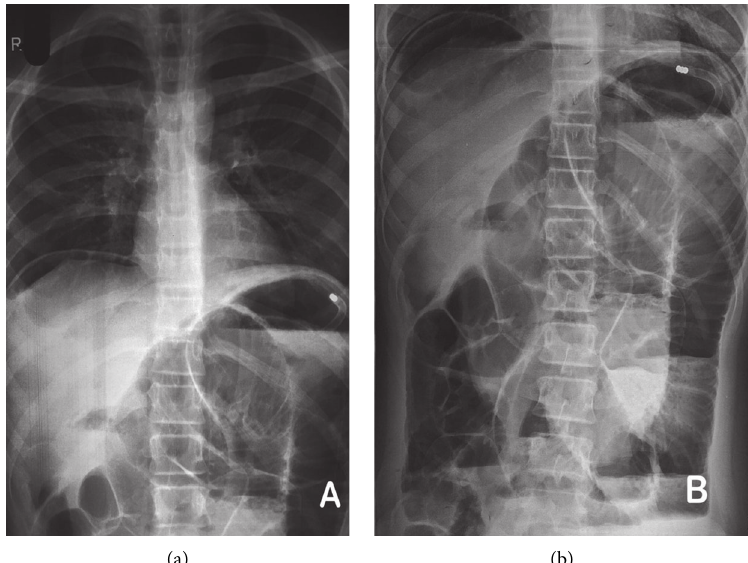
Figure 1: Free subdiaphragmatic extr luminal air and distended small bowel shadow in erect chest X-ray (a) and supine abdominal X-ray (b).